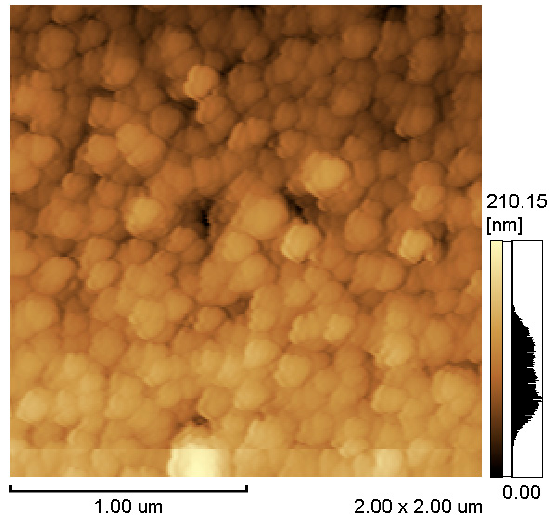
Figure 4. Atomic force microscopy image of the deposited film.